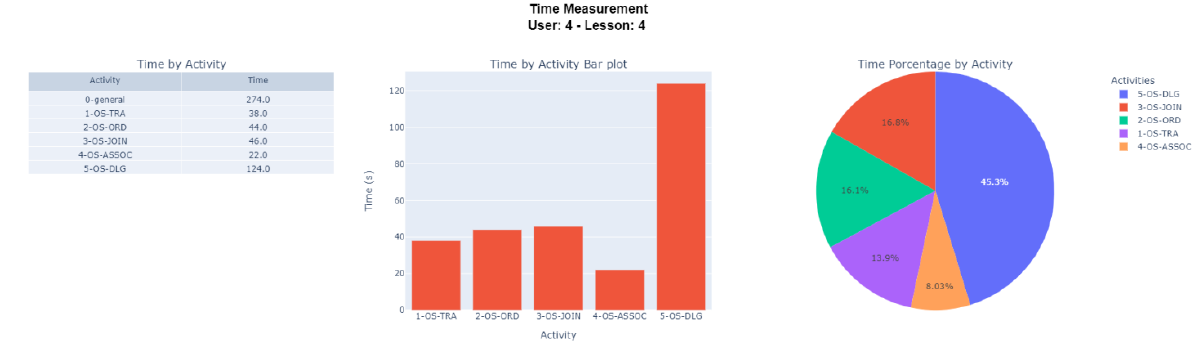
Figure 15. Visualization of time measurements.